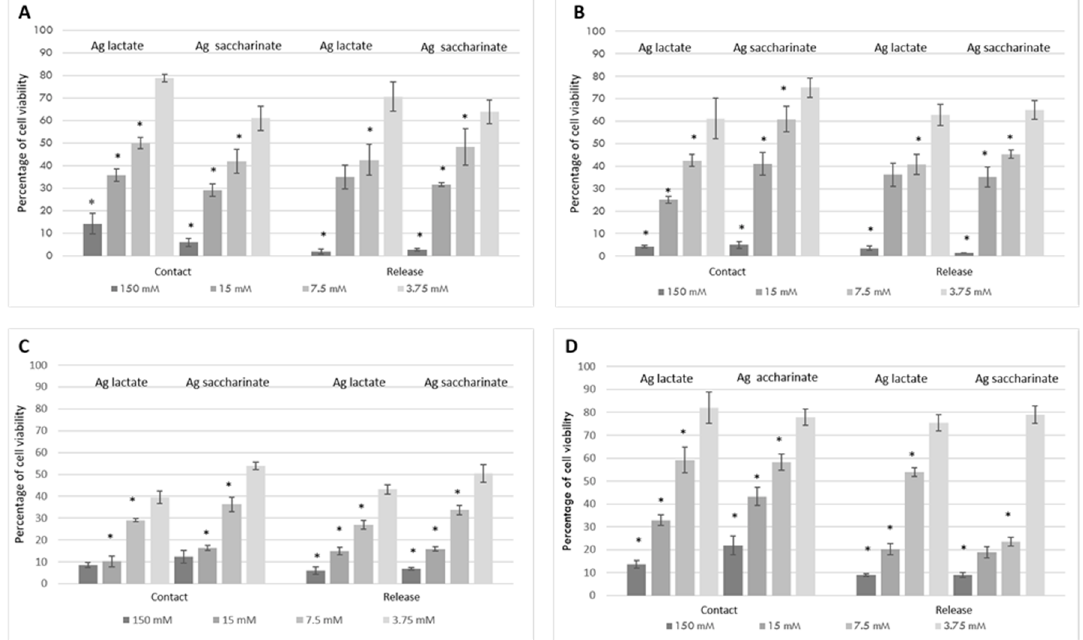
Figure 4. Eukaryotic biocompatibility of silver salts embedded in collagen and alginate beads evaluated by the 3-(4,5 dimethylthiazol-2-yl)-2,5-diphenyltetrazolium bromide (MTT) assay in contact tests and release tests. Cytotoxicity evaluation of silver lactate and silver saccharinate in alginate beads ( a , b ) and in collagen beads ( c , d ); results reported in ( a , c ) are relative to the human fibroblast cell line (MRC-5) whereas in ( b , d ) are reported results obtained with HaCat cells. * p < 0.05 compared to the corresponding lower concentration of silver salt (Bonferroni post hoc test). Bars in the graphs indicate standard errors.